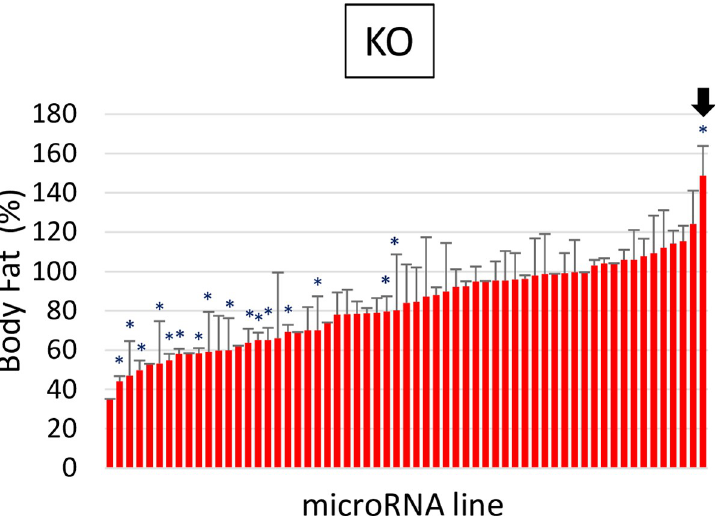
Fig 4. Loss-of-function miRNA heterozygotes altered body fat. MiRNA knock-out (KO) lines were mated with the Act5C-Gal4 driver. The resulting F1 heterozygotes were comparatively analyzed against control flies that were generated from the cross between W 1118 and the same Act5C-Gal4 driver. The relative body fat of each miRNA line was calculated by normalizing each heterozygote’s triglyceride (TG) to the control TG. Relative Body Fat (%) = (TG miRNA /TG control ) X 100, � : P < 0.01 by Student’s t-test. The black arrow shows